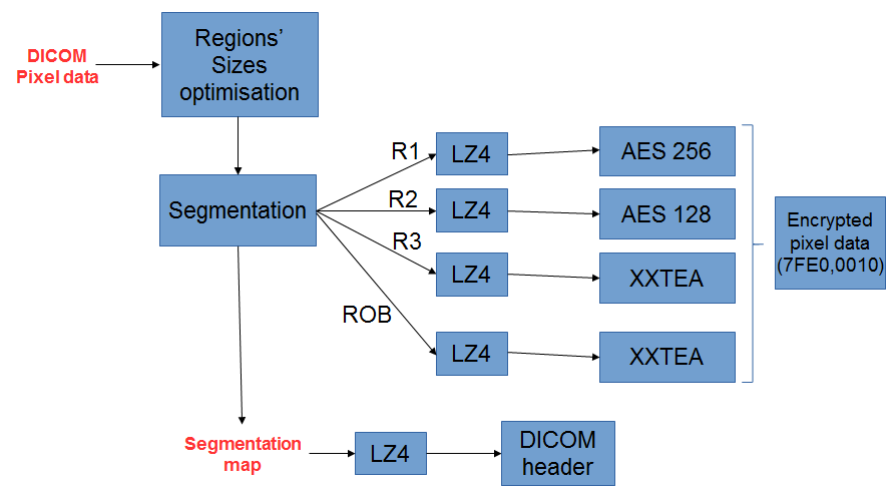
Figure 5. Multi-region encryption process.